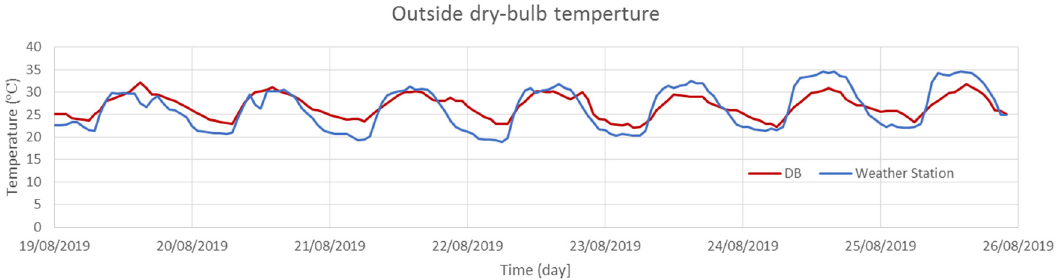
Figure 9. Dry bulb Temperature recorded by the weather station and from the DB climate data file for the Cyprus simulations.